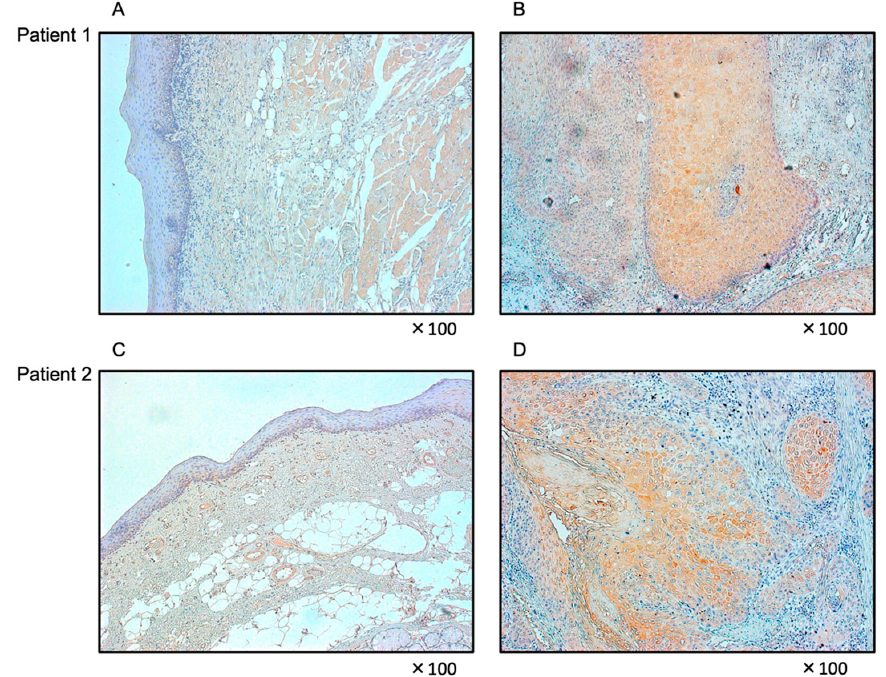
Figure 11. Immunohistochemical staining of FOXD1 in HNSCC clinical specimens. Weak to moderate immunoreactivity of FOXD1 was observed in the cancer lesions ( B , D ) whereas negative immunoreactivity was shown in normal mucosa ( A , C ).